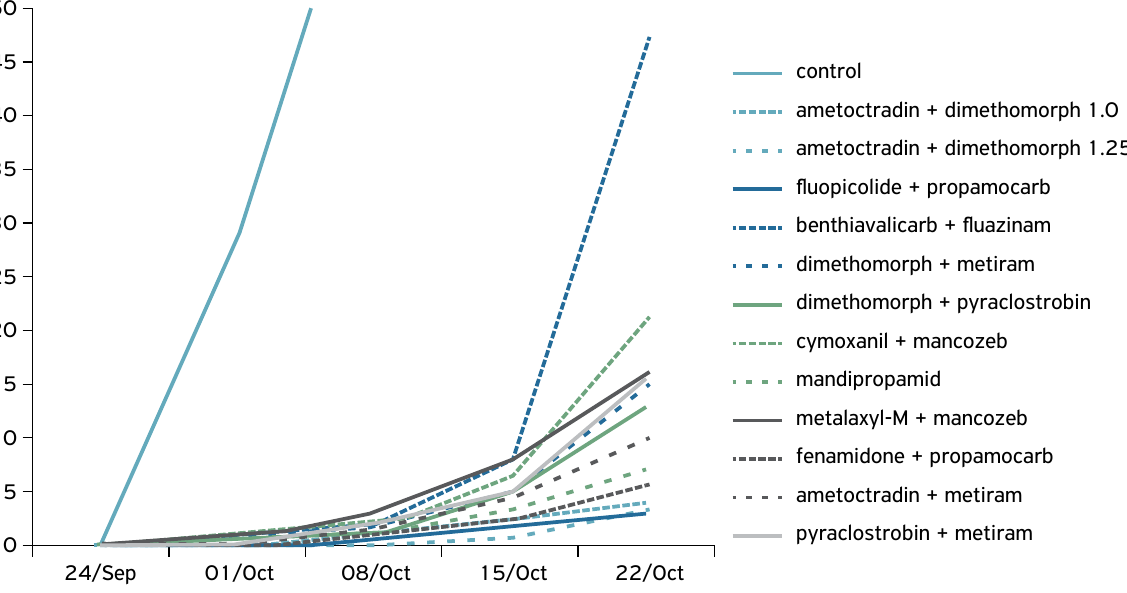
Figure 2. Evolution of late blight in potato plants (cultivar Ágata) treated with fungicides. Pilar do Sul, São Paulo, Brazil, 2013. Leaf severity (0 to 100%) of leaf area affected.